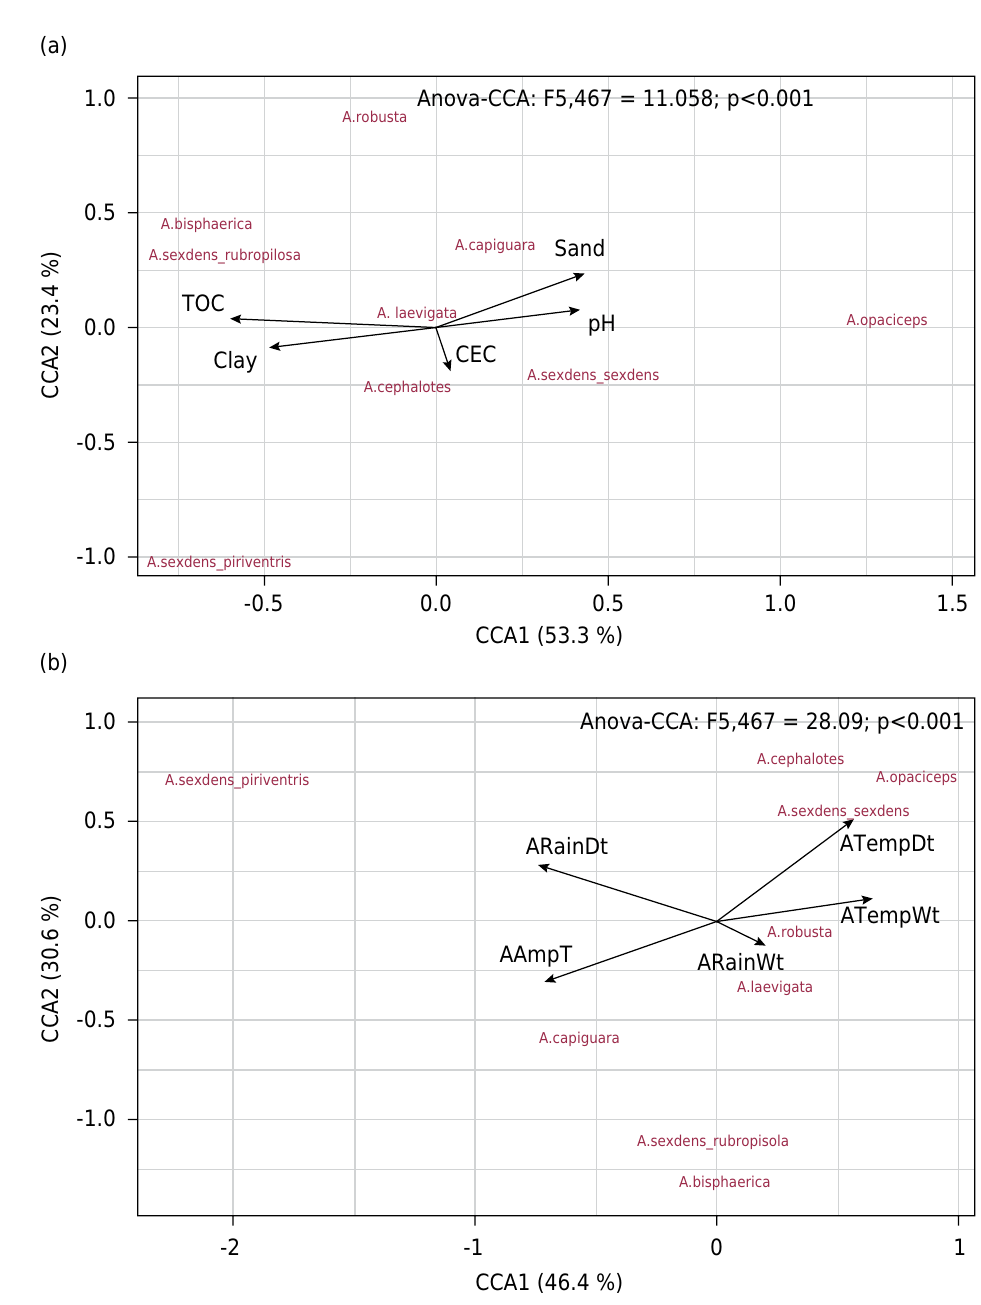
Figure 5. Canonical correspondence analysis (CCA) of soil and climate properties associated with different Atta species occurrence. In A, the soil aspects of Total Organic Carbon (TOC), cation exchangeable capacity (CEC), pH, sand, and clay. In B, the climate attributes of annual average rainfall (AARainf), average rainfall wetter trimester (ARainWt), average rainfall driest trimester (ARainDt), annual amplitude temperature (AAmpT), annual average temperature (AATemp), average temperature wetter trimester (ATempWt), and average temperature driest trimester